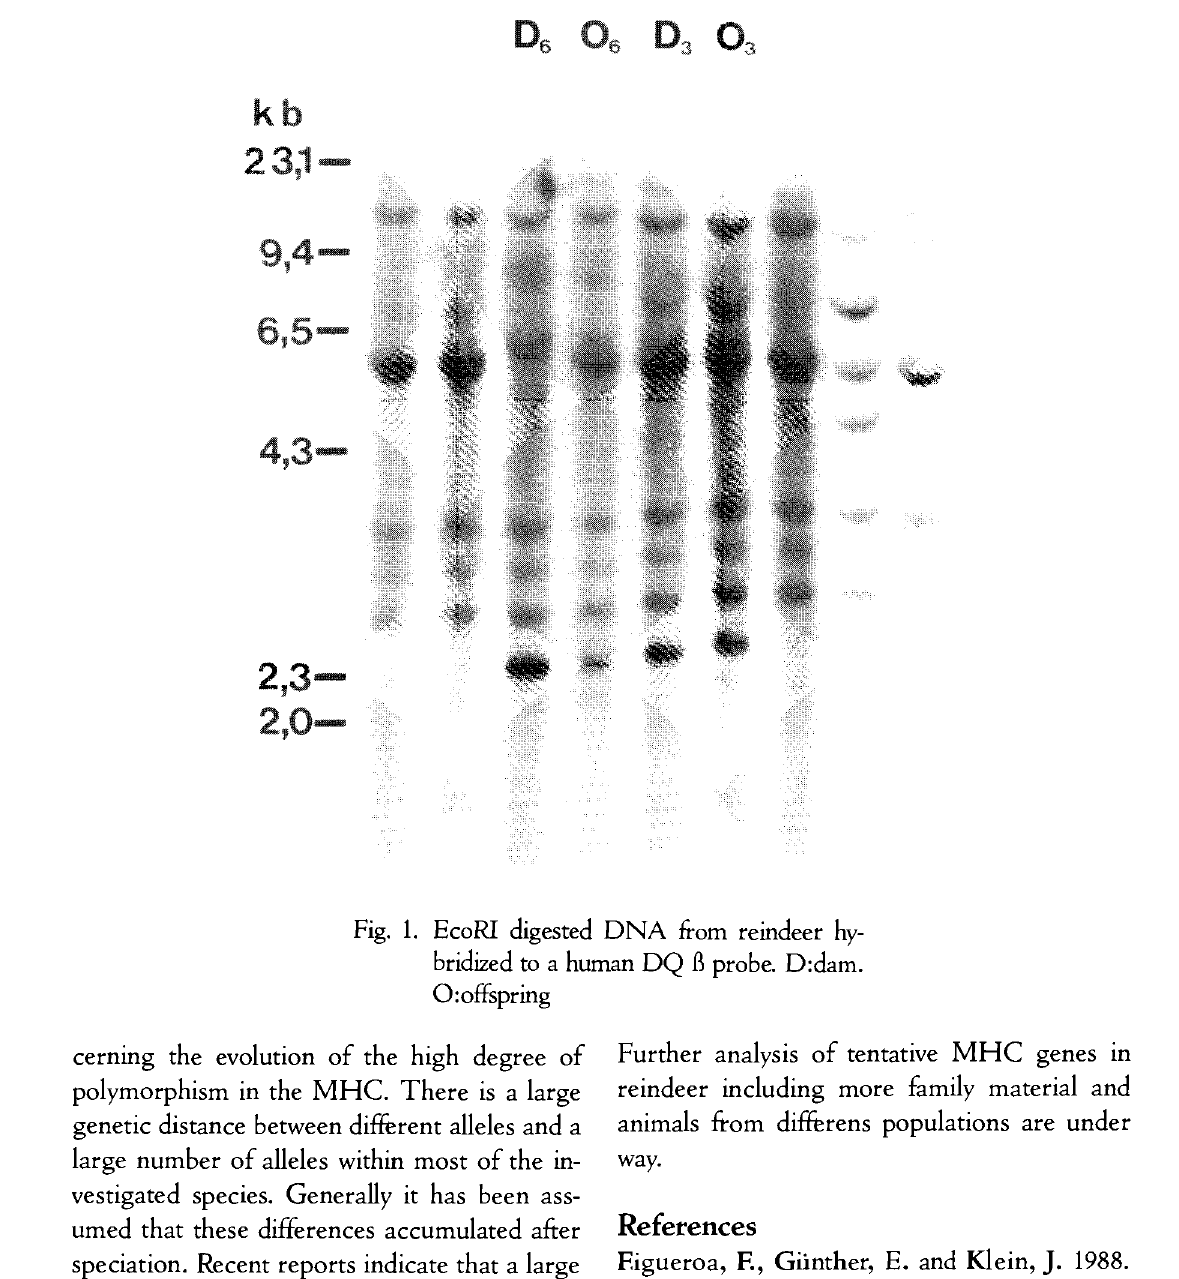
Fig. 1. EcoRI digested D NA from reindeer hy bridized to a human DQ B probe. D:dam. 0:offspring Further analysis of tentative M HC genes in reindeer including more family material and animals from differens populations are under